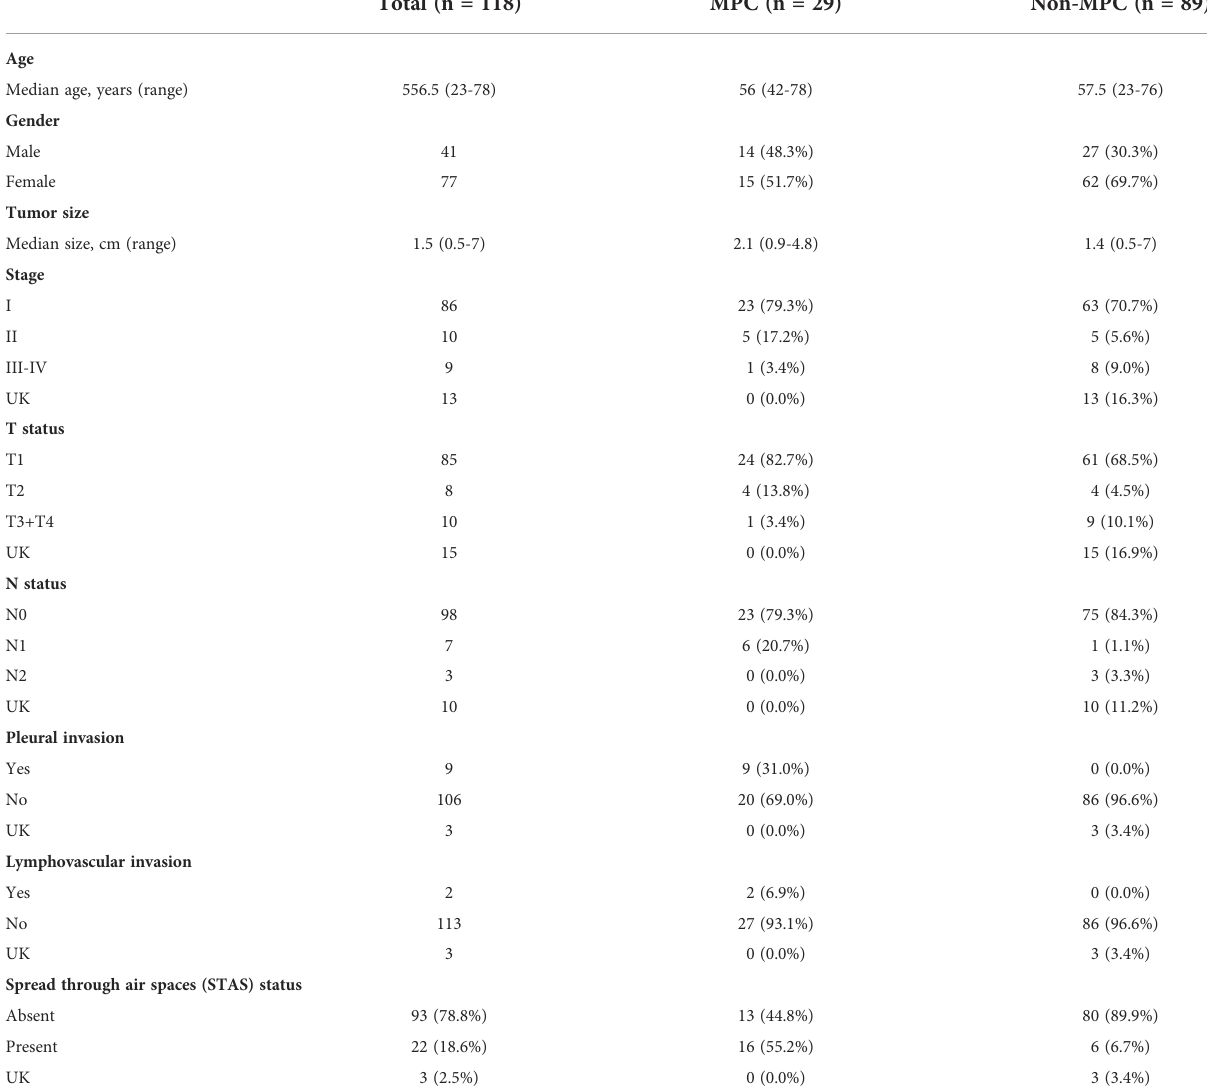
TABLE 2 Clinicopathologic features of lung adenocarcinoma with and without micropapillary pattern. Total (n = 118) MPC (n =